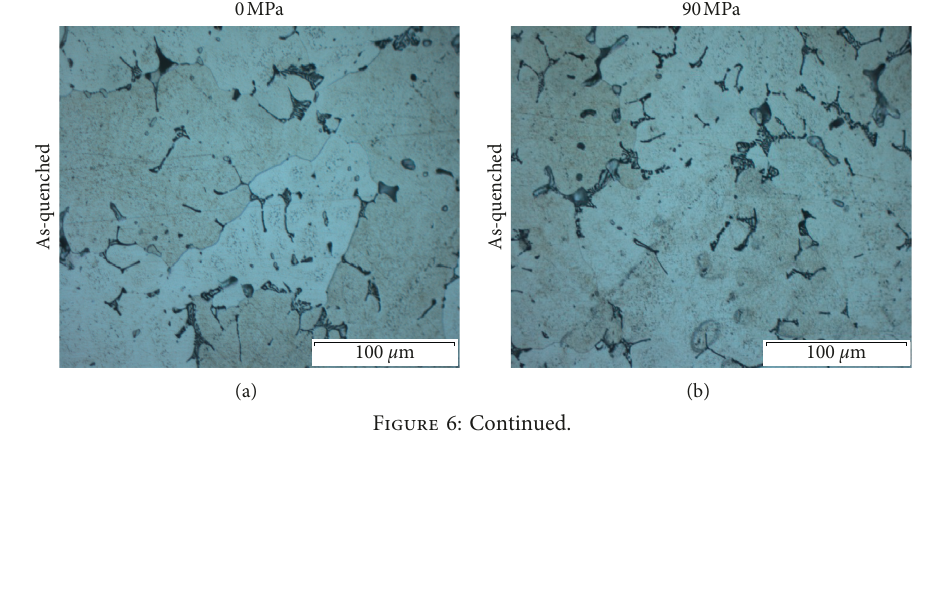
60MPa, and (d) P (cid:31)